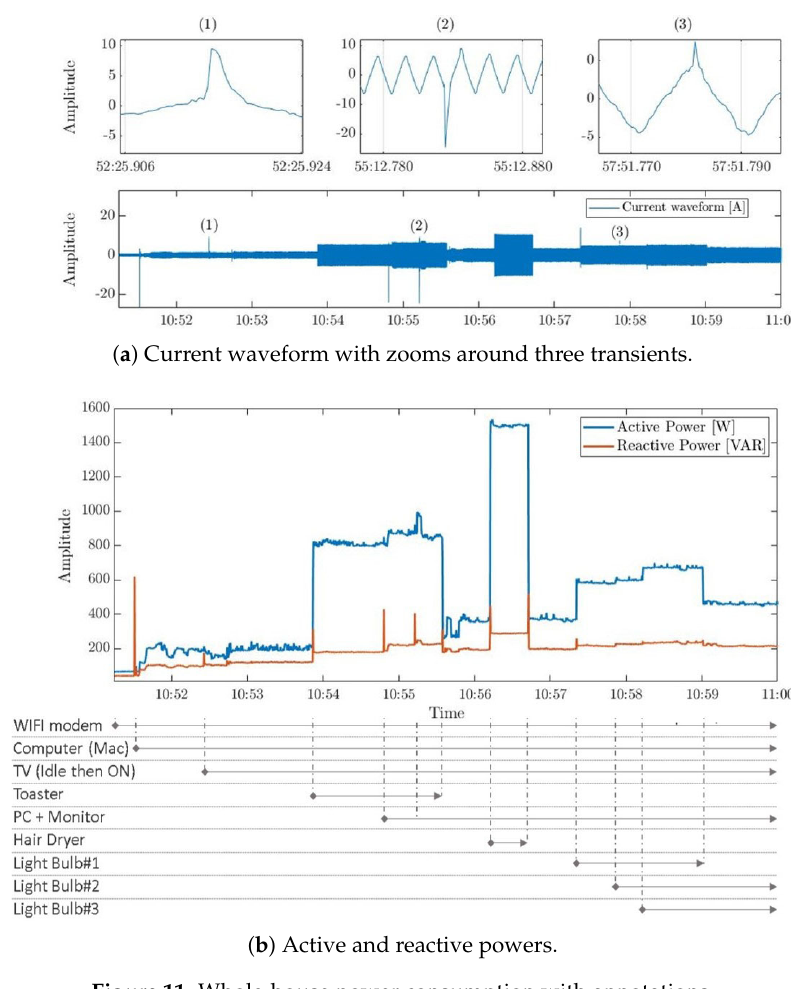
Figure 11. Whole-house power consumption with